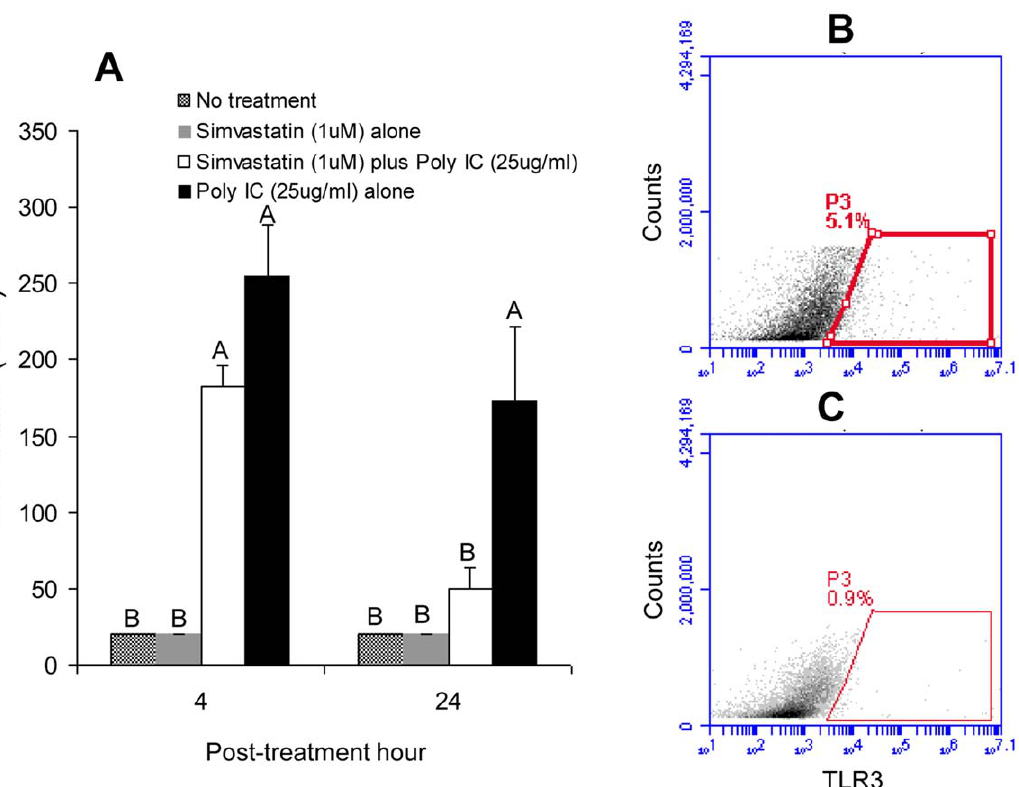
Figure 5. Simvastatin impairs TLR3-mediated induction of type I IFN and diminishes IFN- a levels from pulmonary macrophages (PAMs) invitro, possibly due to lowered expression of TLR3 after treatment. The PAMs (2 , 4 6 10 6 cells/ml) were first treated with 1 m M simvastatin, and 24 hours later, were treated with either simvastatin (1 m M) or poly (I:C) (25 m g/ml), or treated with both. The cell culture supernatants were harvested to measure IFN- a levels ( A ) by biological assay at 4 and 24 hours afters poly (I:C) treatment. Each bar represents the mean 6 SEM. Different letters denote significant differences among groups at each time-point (ANOVA test, P , 0.05). ( B, C ) Flow cytometry of TLR3 + cells after simvastatin treatment. PBMC-derived macrophages (2 , 5 6 10 6 cells/ml) were first treated with 1 m M simvastatin, and 24 hours later, were treated with either simvastatin (1 m M) or poly (I:C) (25 m g/ml), or both. Cells were harvested at 24 hours afters poly (I:C) treatment and stained intracellularly for TLR3. (B) represents cells from poly (I:C) alone treatment and (C) represents cells from simvastatin + poly (I:C) treatment. A total